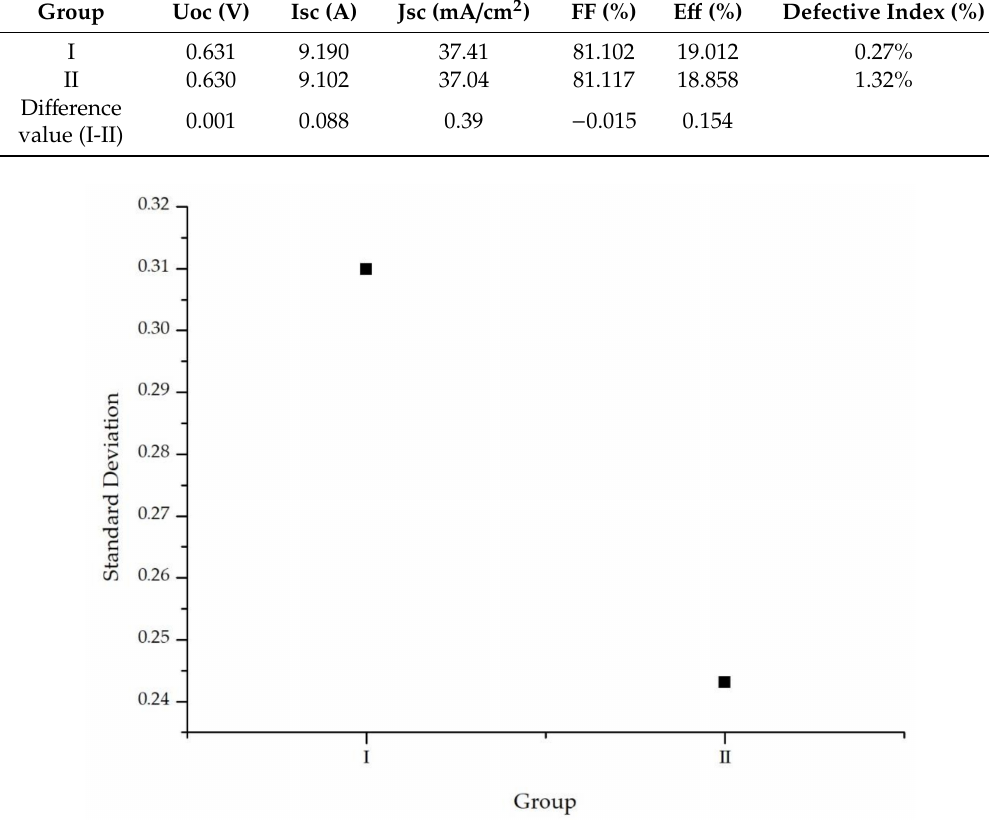
Figure 7. The standard deviation of the cells Jsc of two